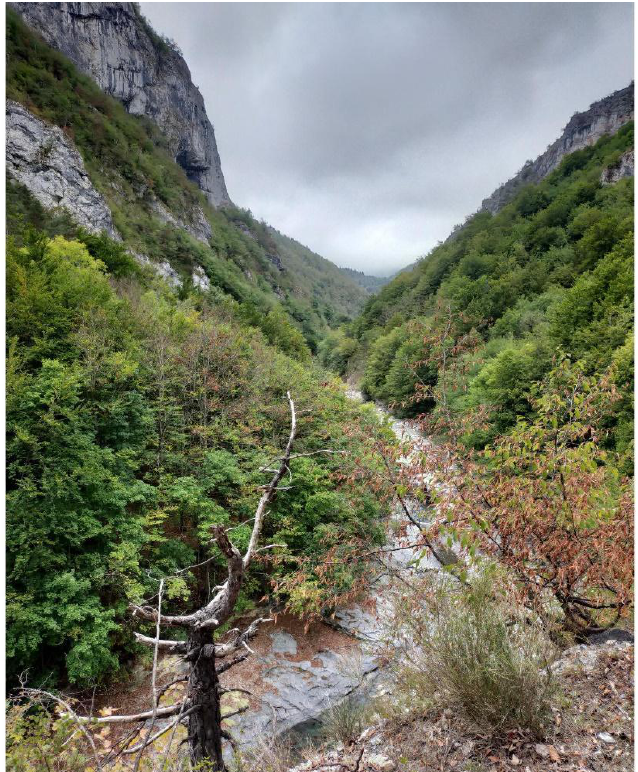
Figure 6. Picture of Tanarello Valley towards site 2.